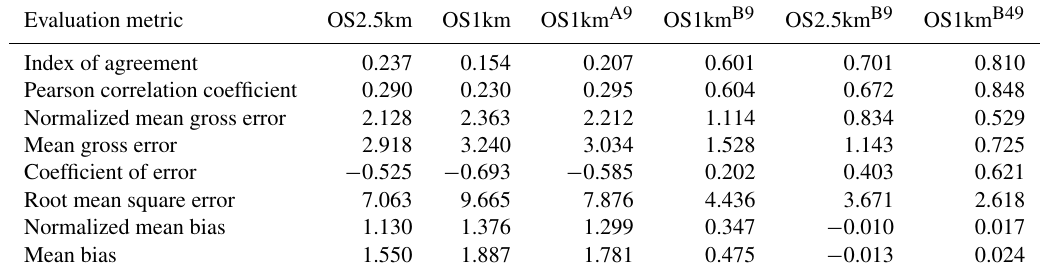
Table 2. Surface SO 2 observations to model comparison for entire simulation period (ppbv, 5466 model–observation pairs). Evaluation metric